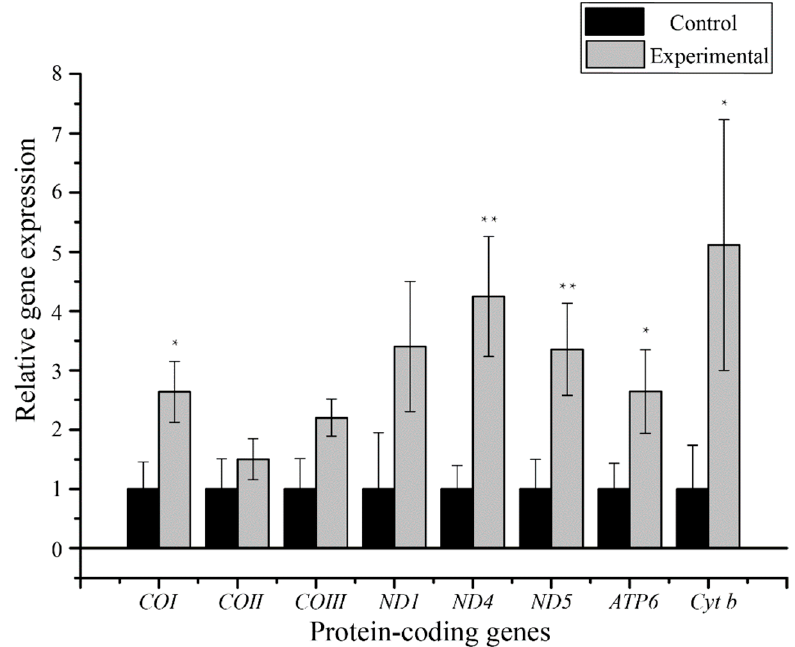
Figure 4. The expression of eight protein-coding genes from M. alternatus carrying B. mucronatus or not. The x-axis shows gene names, and the y-axis shows relative gene expression. Black columns show controls, standardized to 1.0; gray columns show the corresponding experimental group (carrying B. mucronatus ). Asterisks indicate significantly different expression: *, p < 0.05); **, p < 0.01.